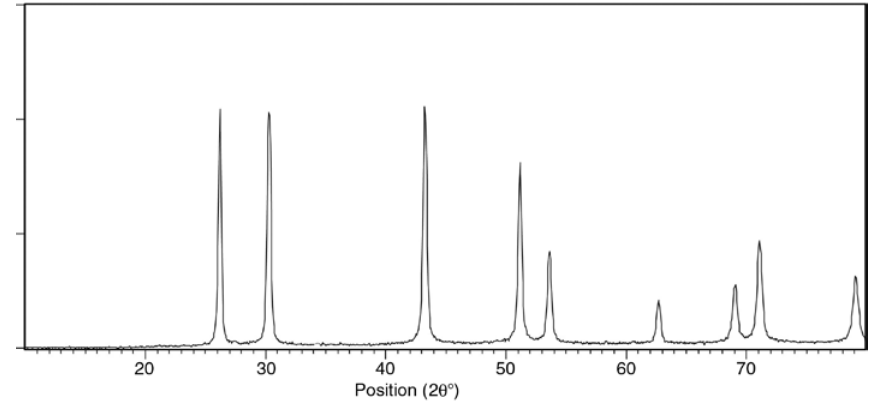
Figure 1: XRD pattern of PbS nanoparticles.